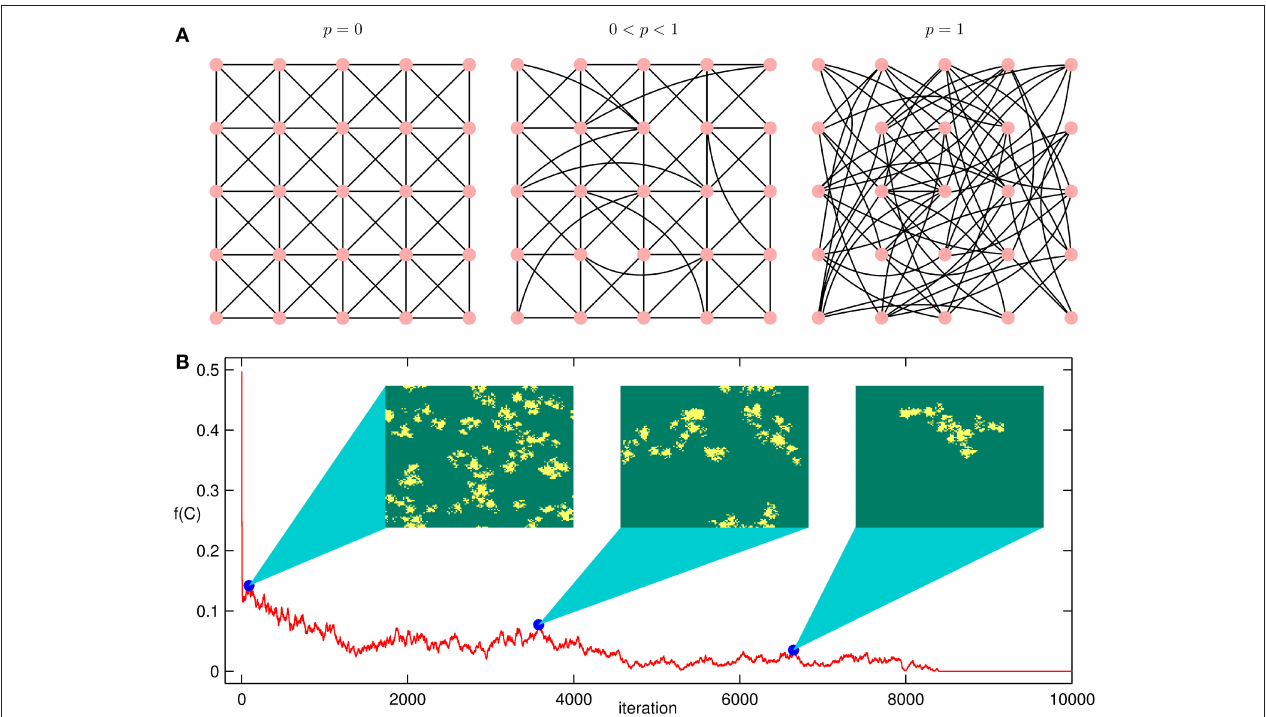
FIGURE 2 | (A) Schematic illustrating the rewiring procedure for generating networks using the small-world construction paradigm [42]. Beginning with a system of nodes connected in a lattice topology [left], the decision to randomly rewire each link is specified by a probability p . For the extreme case p network that, if sufficiently dense, has the properties of an Erdös-Rényi network [right], while for intermediate values of p the resulting network [center] exhibits so-called “small-world” characteristics, viz., a high clustering coefficient and a small average path length. These networks are used here to investigate the role of connection topology on the collective dynamics in spatially extended versions of IPD. (B) A characteristic time-series of the fraction f ( C ) of cooperators in a lattice of N 128 128 agents. Each agent plays IPD with their 8 nearest neighbors. The result shown is obtained using a temptation b = × Initially, 50 % of the agents are randomly selected to be cooperators. Snapshots of the lattice are displayed at three instants denoted by the filled circles on the time series. In each snapshot, cooperators are marked as yellow and defectors as green. Periodic boundary conditions have been assumed.